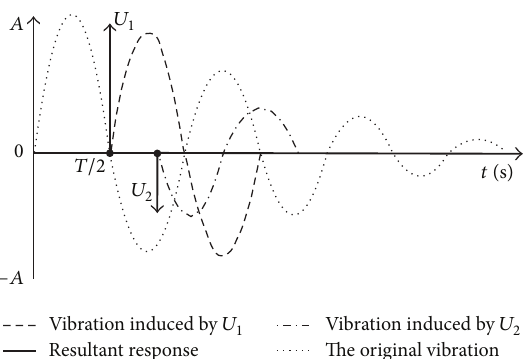
Figure 7: The principle of double-impulse